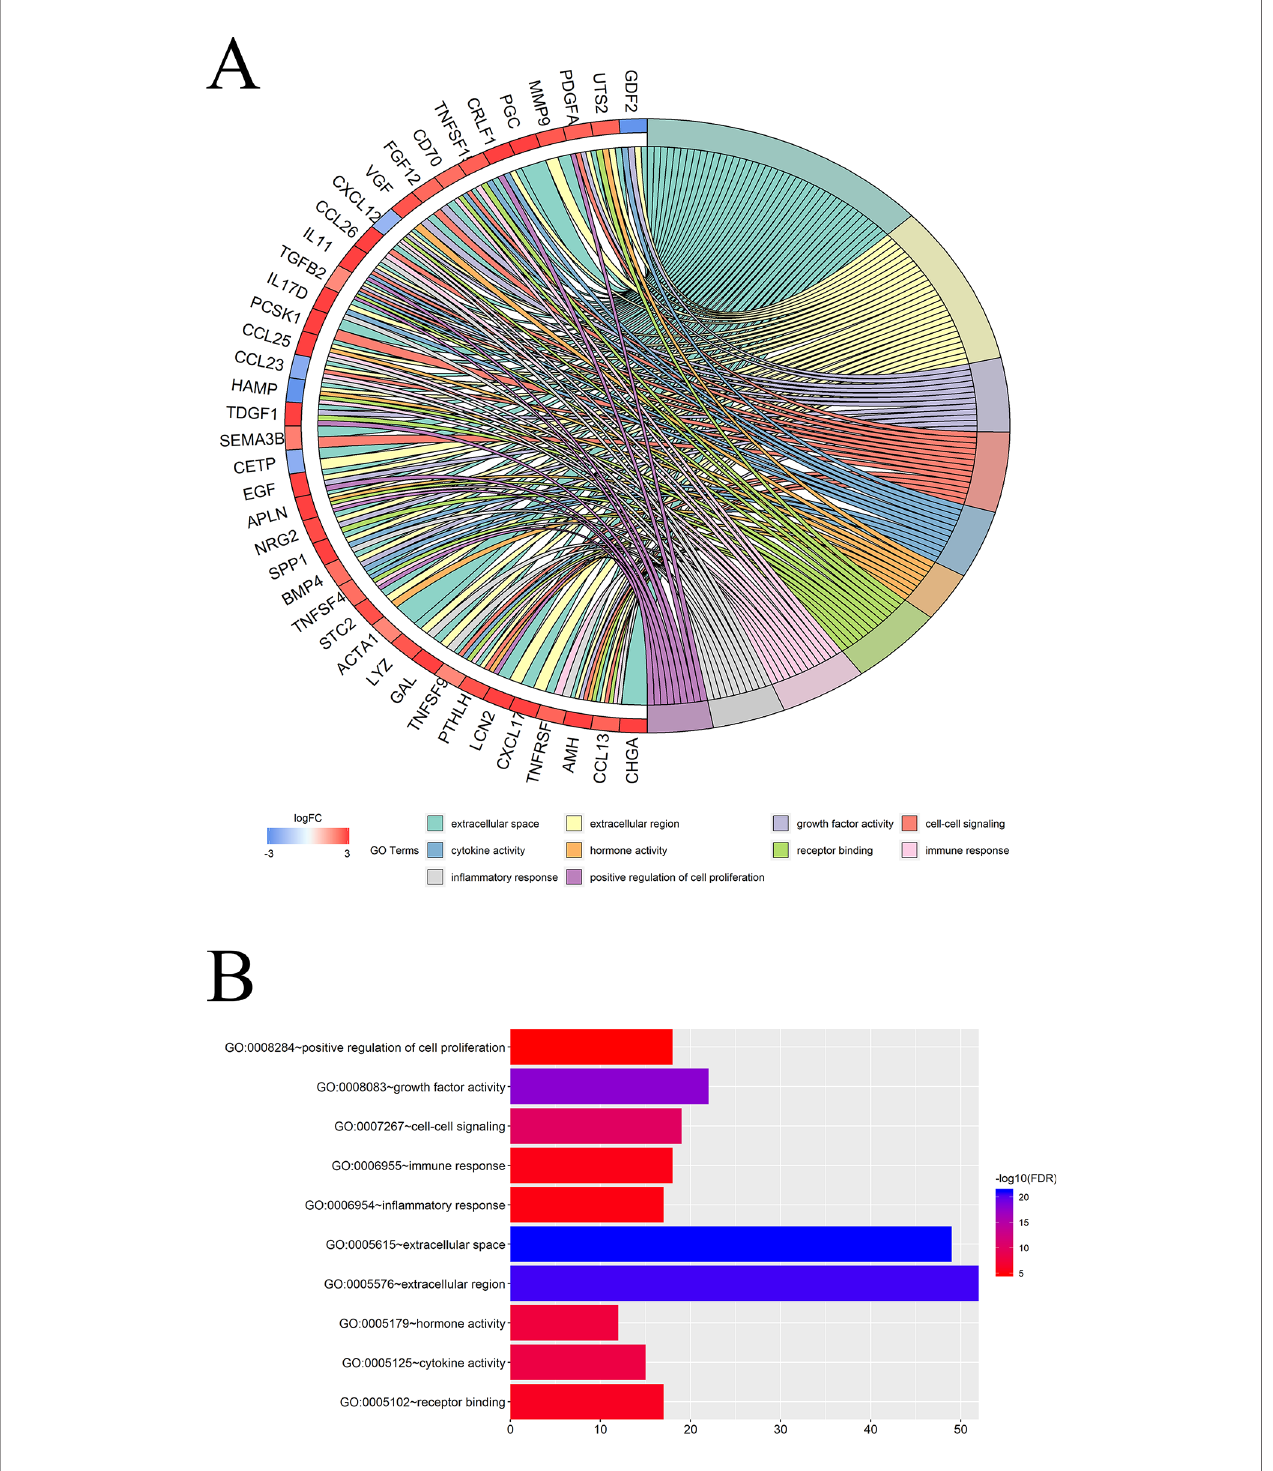
FIGURE 4 | Functional enrichment analysis of DEIRGs: (A, B) GO biological process